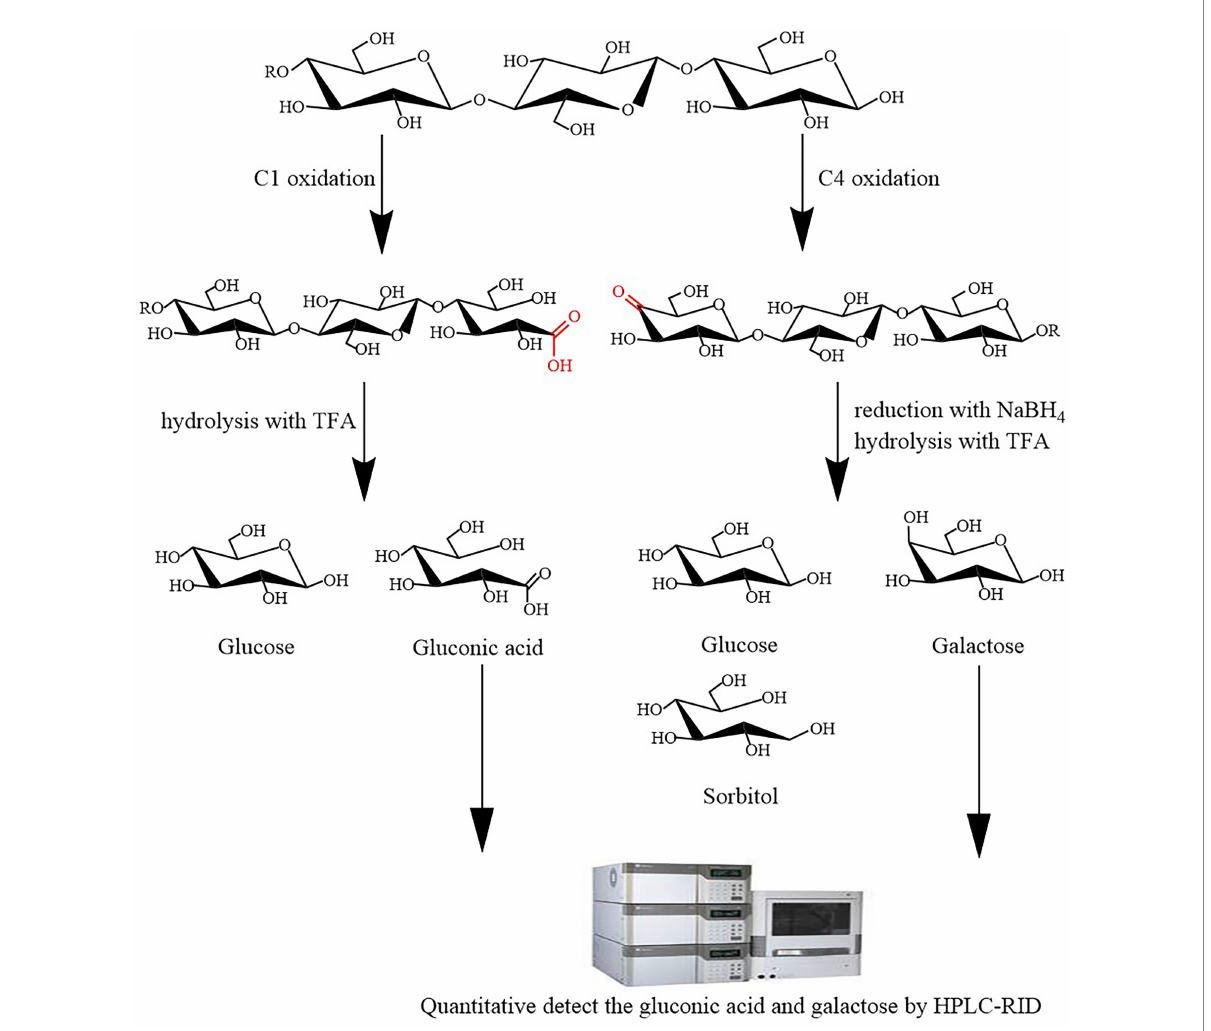
FIGURE 1 Schematic of the lytic polysaccharide monooxygenase (LPMO) activity assay. LPMO oxidatively cleaves cellulose to yield C1 and C4 oxidation products. Trifluoroacetic acid (TFA) can hydrolyze the products of LPMO C1 oxidation to yield glucose and gluconic acid, and the products of LPMO C4 oxidation can be reduced by NaBH4 and then hydrolyzed by TFA to yield glucose, galactose, and sorbitol. high-performance liquid chromatography–refractive index detector (HPLC-RID) can quantitative detect the resulting gluconic acid and galactose to estimate LPMO C1 and C4 oxidation